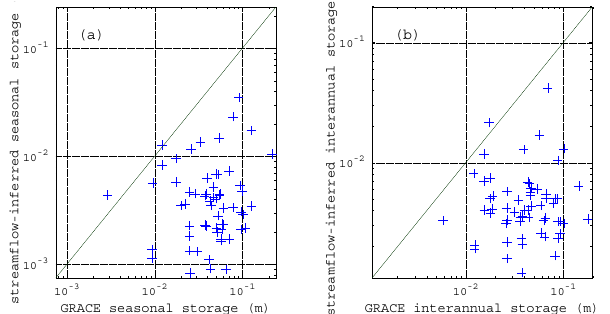
Fig. 8. Scatter of the amplitude of (a) seasonal and (b) interannual water storage variability inferred from the recession curve vs. that inferred from GRACE gravimetry for the 61 watersheds, quantified as the standard deviation of (a) the mean seasonal cycle and (b) de- seasonalized monthly values. Amplitudes inferred from recession curve analysis are generally low compared to GRACE (the solid lines correspond to 1-1